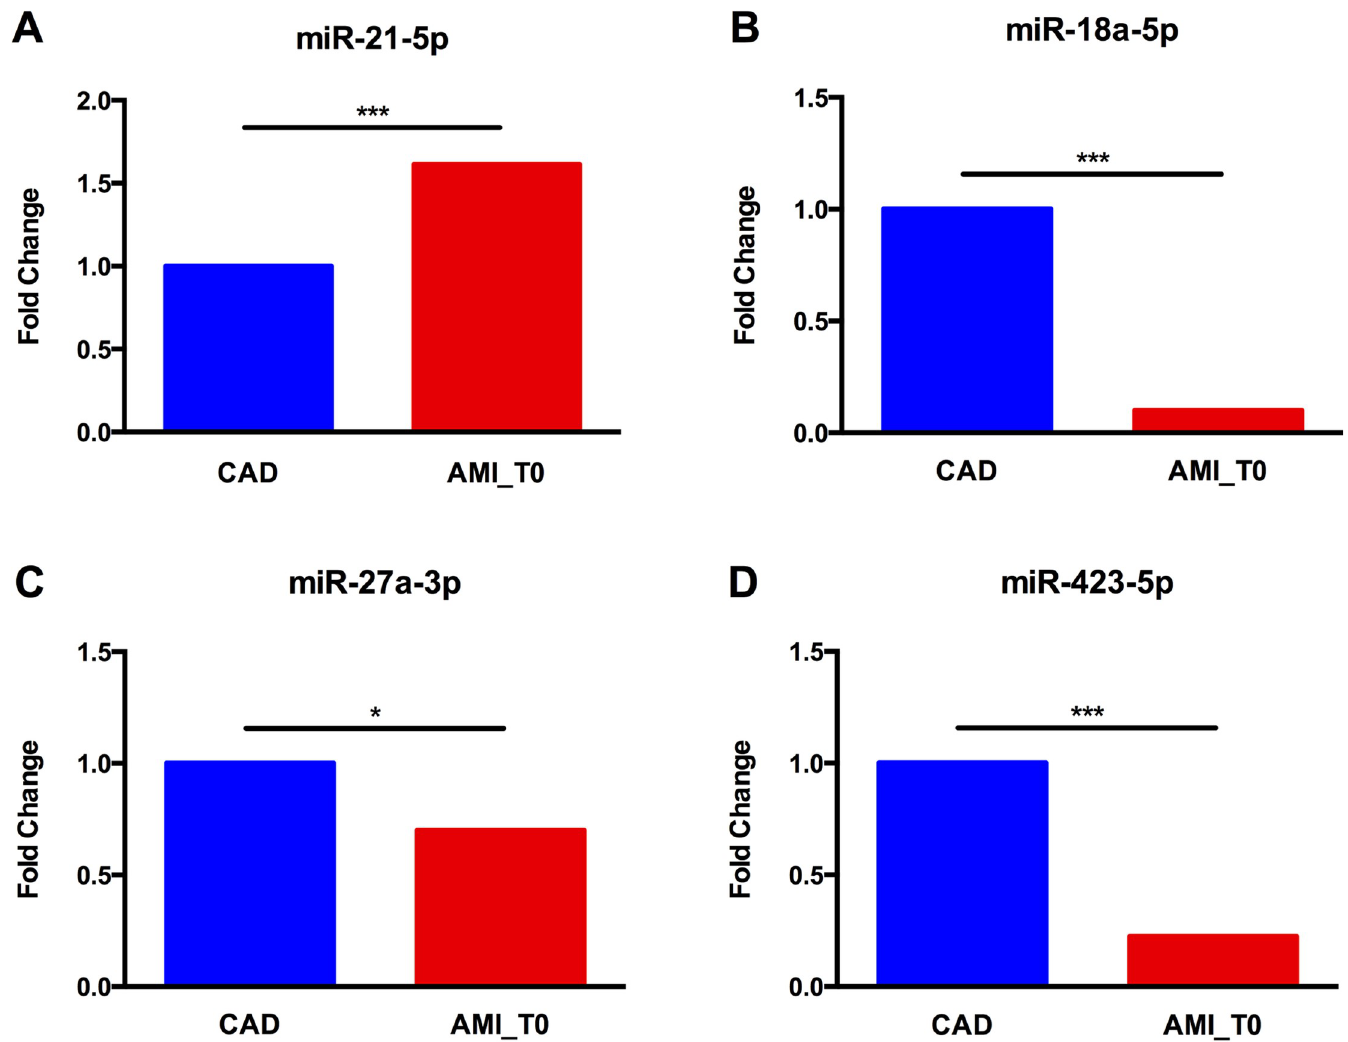
Fig 2. MiR-21-5p, miR-18a-5p, miR-27a-3p and miR-423-5p expression in AMI_T0 and CAD pools. Student T test, � p � 0.05, ��� p � 0.0005 (n =